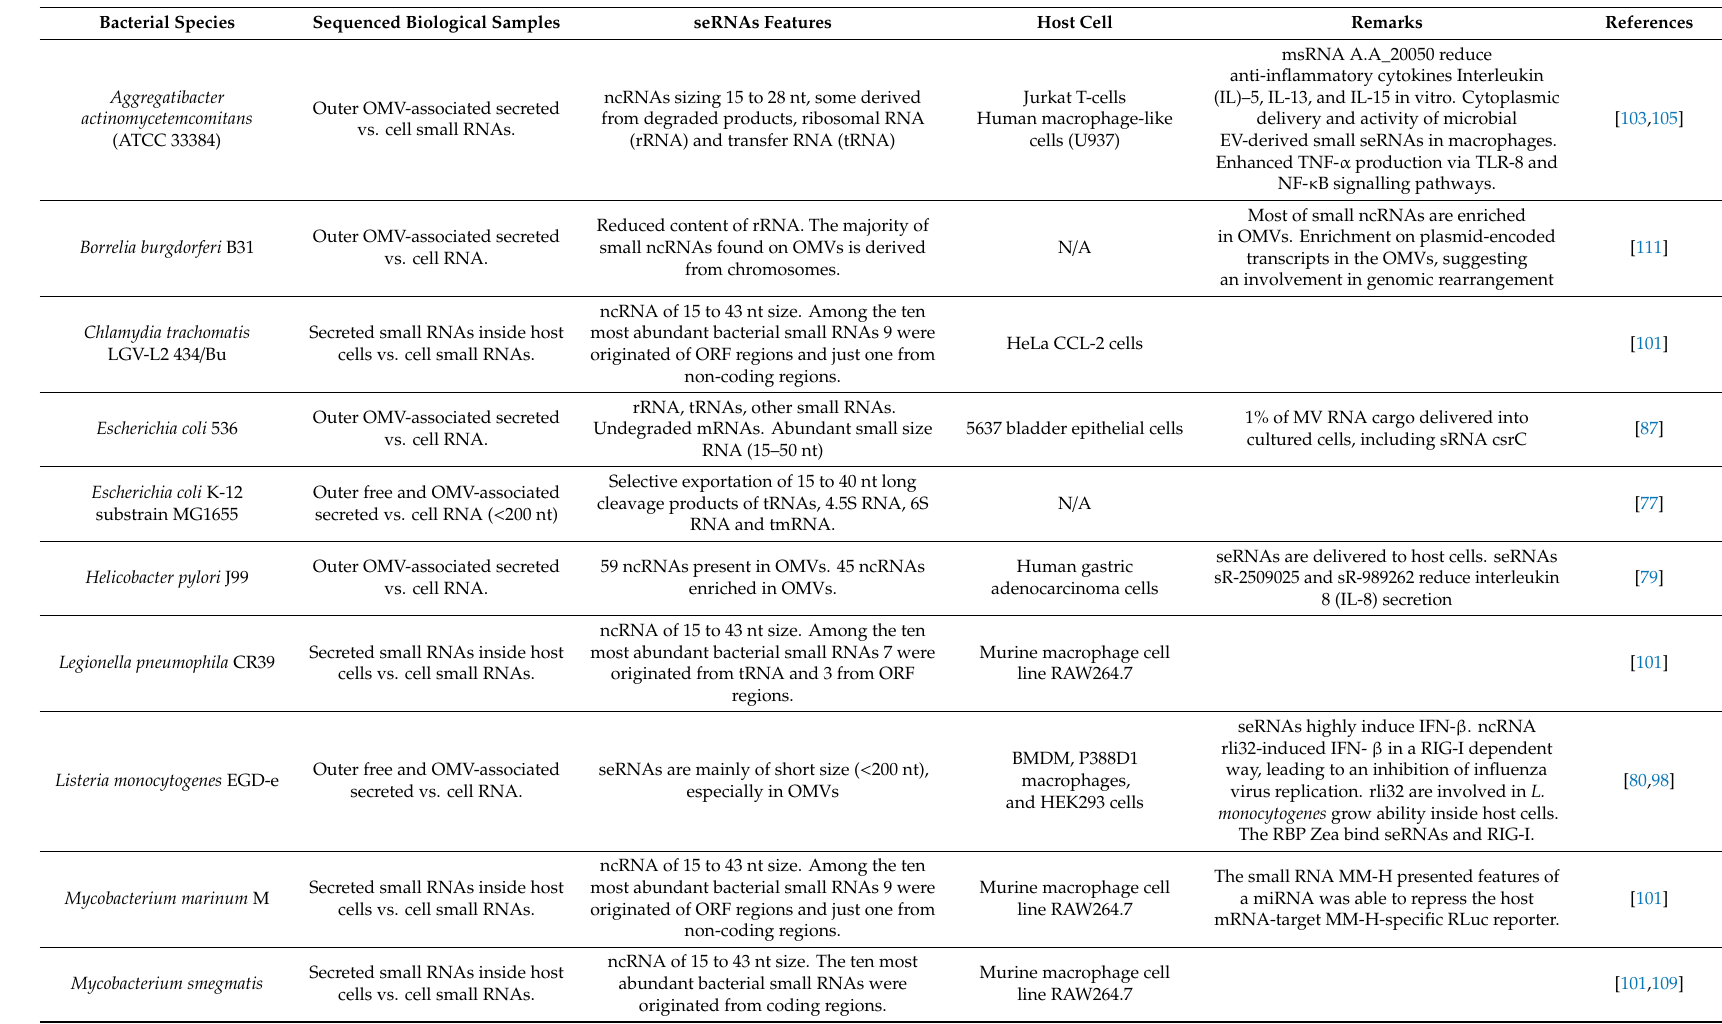
Table 1. Description of secreted RNAs by di ff erent bacterial